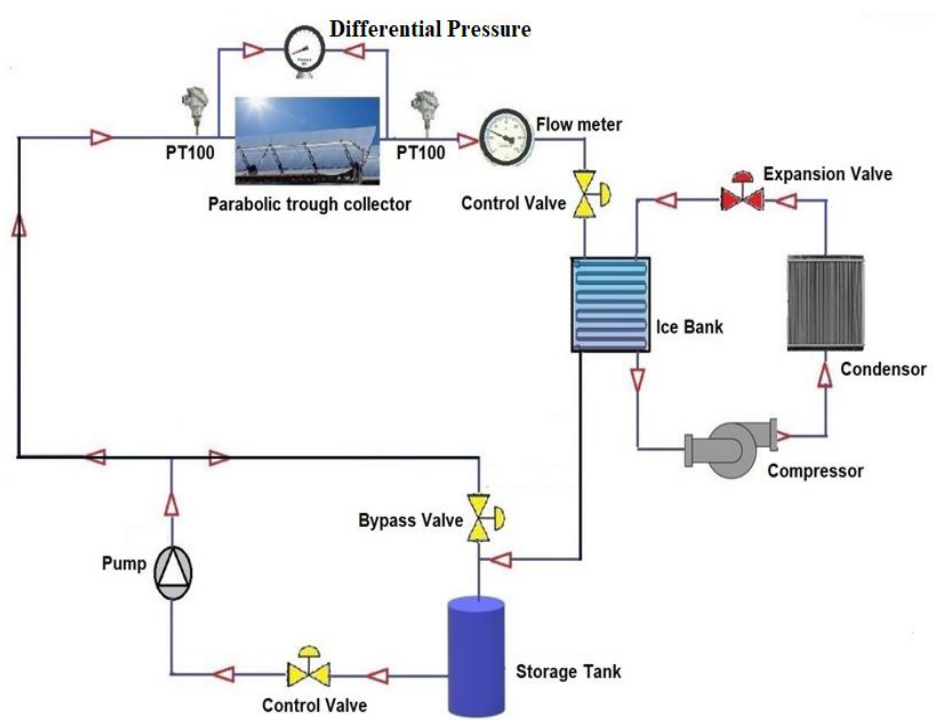
Figure 1. Schematic diagram of direct absorption parabolic trough collector working cycle.